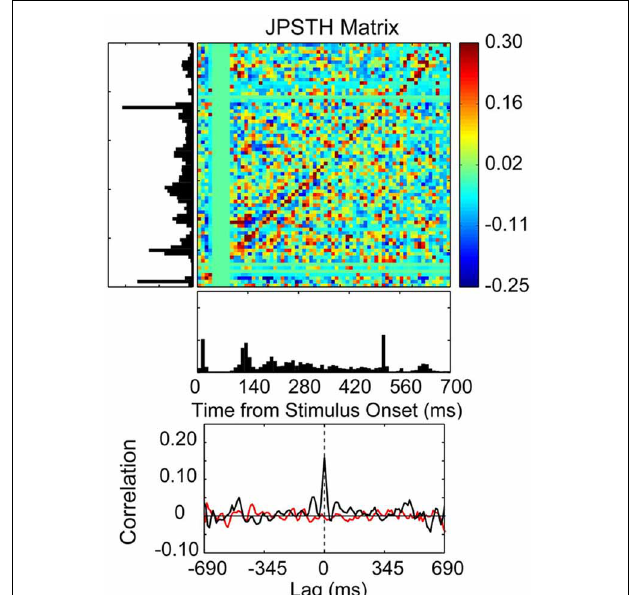
FIGURE 7 | Correlated spike activity recorded from adjacent electrodes in a 10 × 10 multielectrode array recording from the thenar pad representation of area 3b in an owl monkey. Spike synchrony between two neurons is shown in a JPSTH matrix, with a psth for each neuron shown to the left and below to illustrate responses to skin indentations of the thenar pad and digital (P1) pad for 100 trials. The colored pixels in the JPSTH matrix represent the magnitude of the normalized correlation at different lag times over a poststimulus time of 700ms. The magnitude of the normalized correlation shown in the JPSTH and in the cross-correlation histogram reveal a strong spike synchrony that occurred at 0ms lag time. The cross-correlation histogram (black) revealed a peak correlation of 0.16 that exceeded the mean correlation from the shuffled trials (red). The time-averaged cross-correlogram was computed by summing the JPSTH bins parallel to the main diagonal, measuring the average positive or negative correlation across the entire interval of analysis in 1ms bins [reprinted with permission from Reed et al.